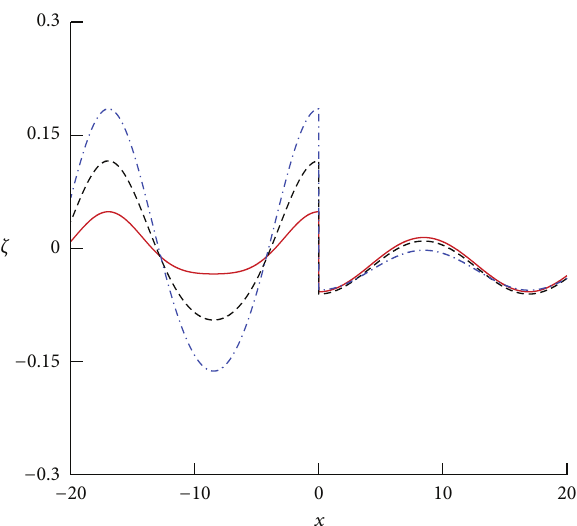
Figure 5: Variation of incident progressive waves and hydroelastic deflection of the plate versus 𝑥 for different values of Young’s modulus 𝐸 of the plate. Solid line: 𝐸 = 10 8 Pa; dashed line: 𝐸 = 10 9 Pa; dash-dotted line: 𝐸 = 10 10 Pa.